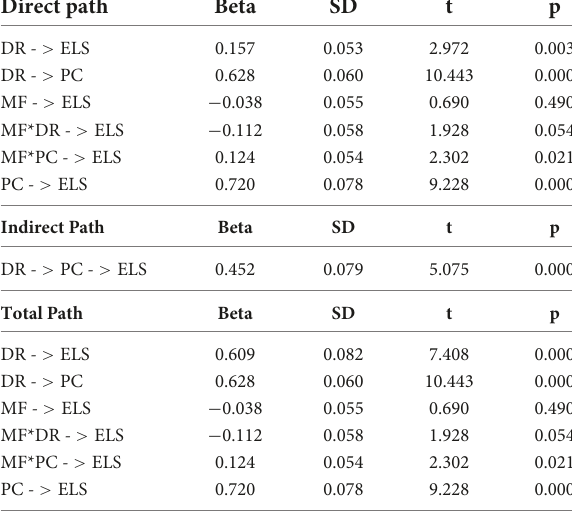
TABLE 4 Direct, indirect, and total path